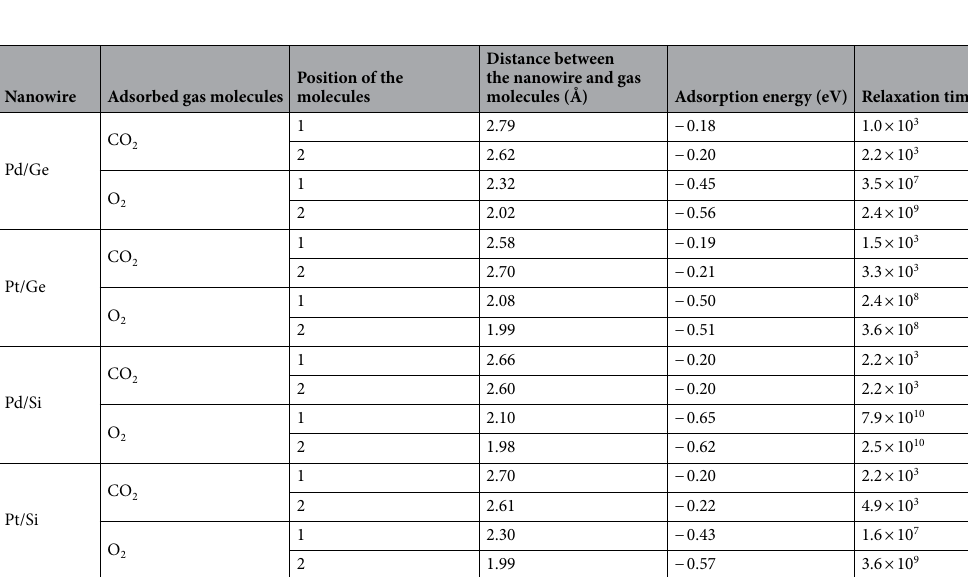
Table 2. Calculated distance between the nanowire and gas molecules, adsorption energy and relaxation time of the gas molecules.